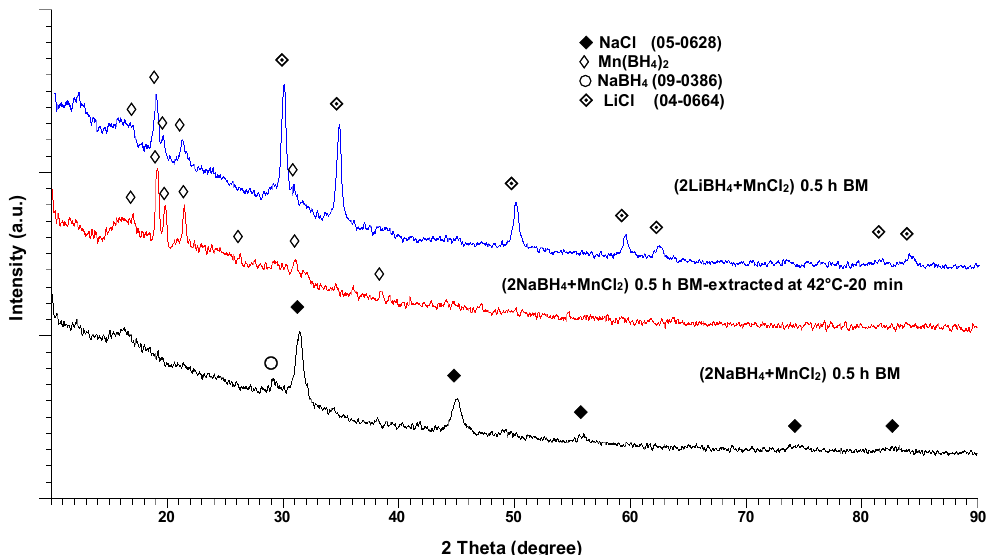
Figure 8. XRD patterns of the 0.5 h BM sample, solvent extracted at 42 °C for 20 min ( center ) in comparison to the XRD patterns of the 0.5 h BM (2NaBH 4 + MnCl 2 ) ( bottom ) and (2LiBH 4 + MnCl 2 ) ( top ) samples. From Varin et al. [11].